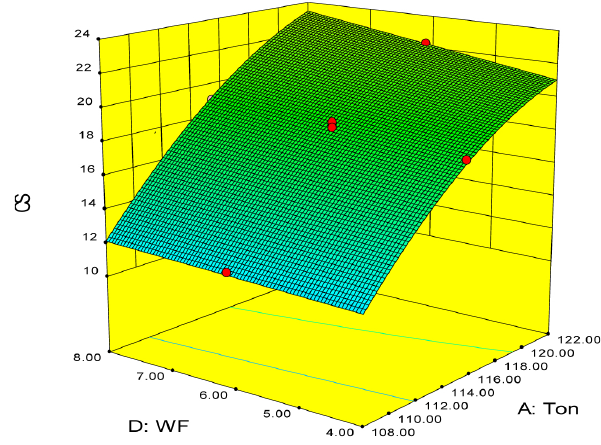
Figure 6a. Combined e ff ect of T on and T o ff on CS.